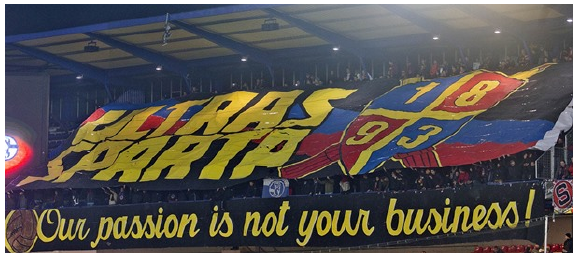
Figure 4. ULTRAS at Letna Stadium